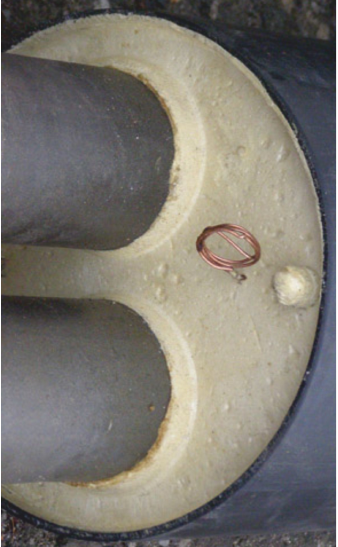
Figure 6. View of pre-insulated double pipes.